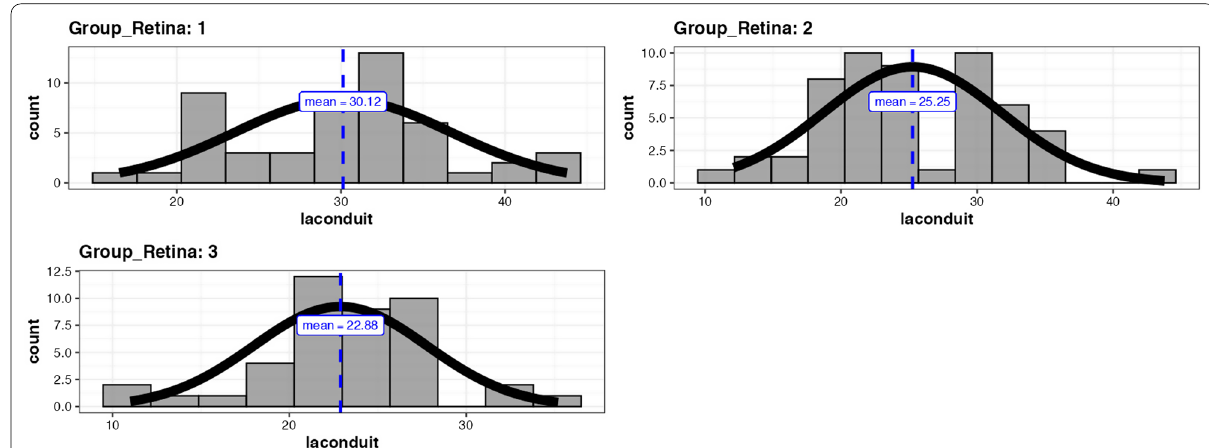
Fig. 2 Density histogram of LA contractile strain values of the three groups